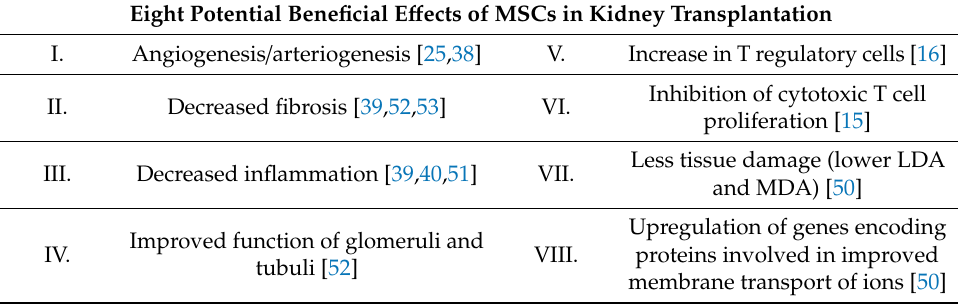
Table 2. Eight potential beneficial e ff ects of MSCs in kidney